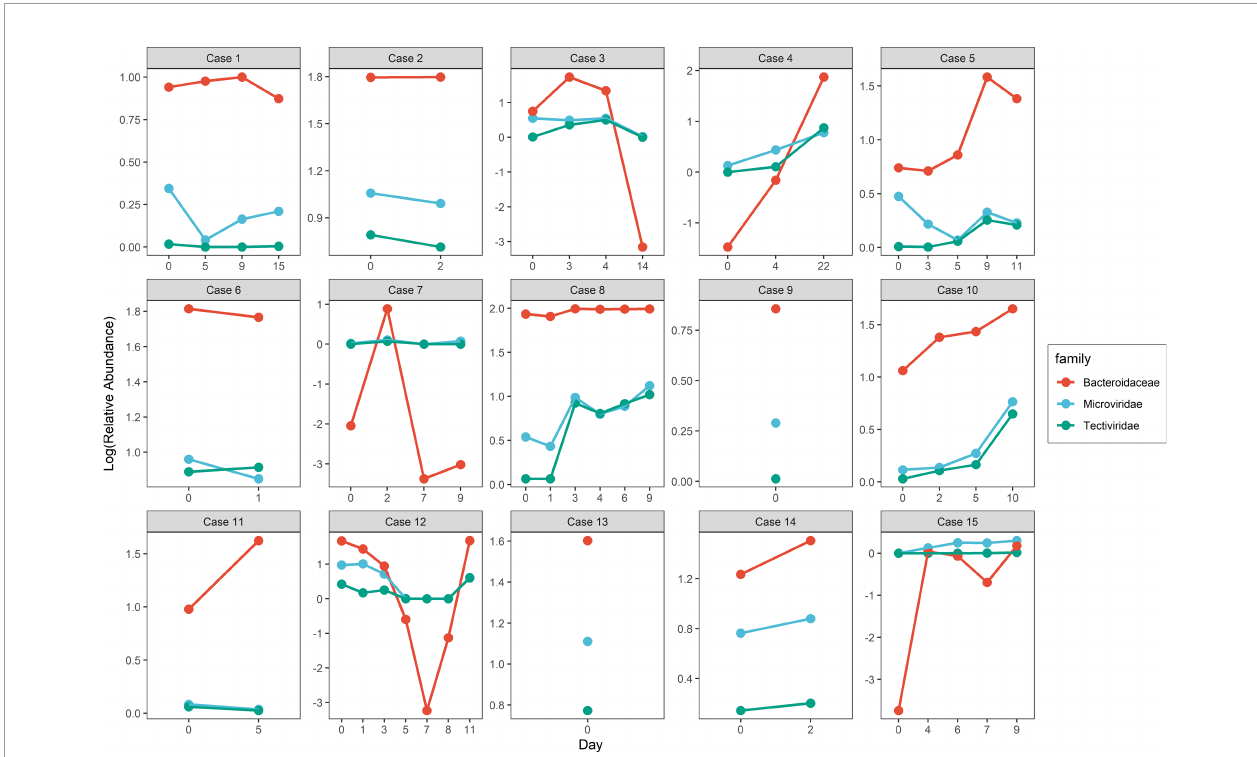
FIGURE 3 | Alteration of viral and bacterial relative abundance in similar trend along hospitalization within COVID-19